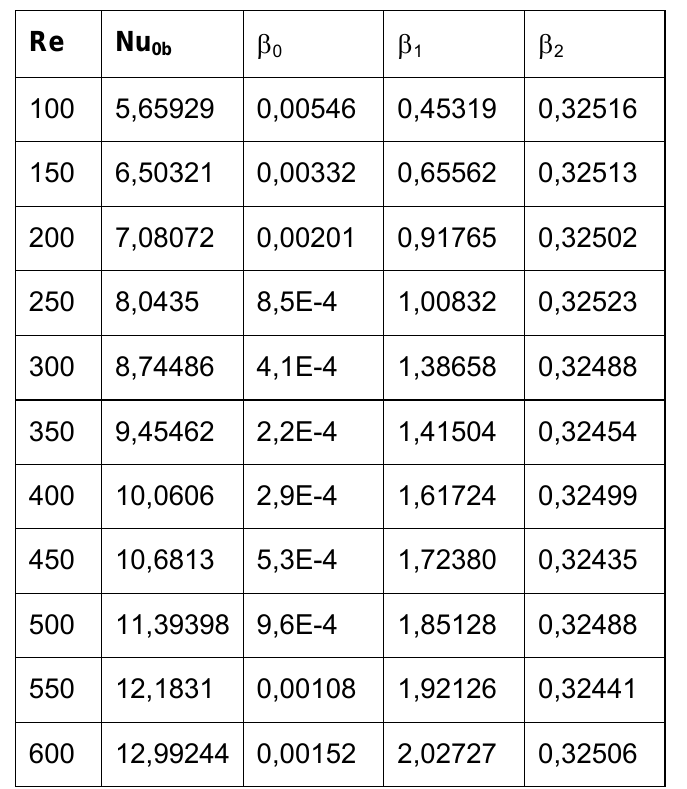
Table 1. Values of coefficients as a function of the Reynolds